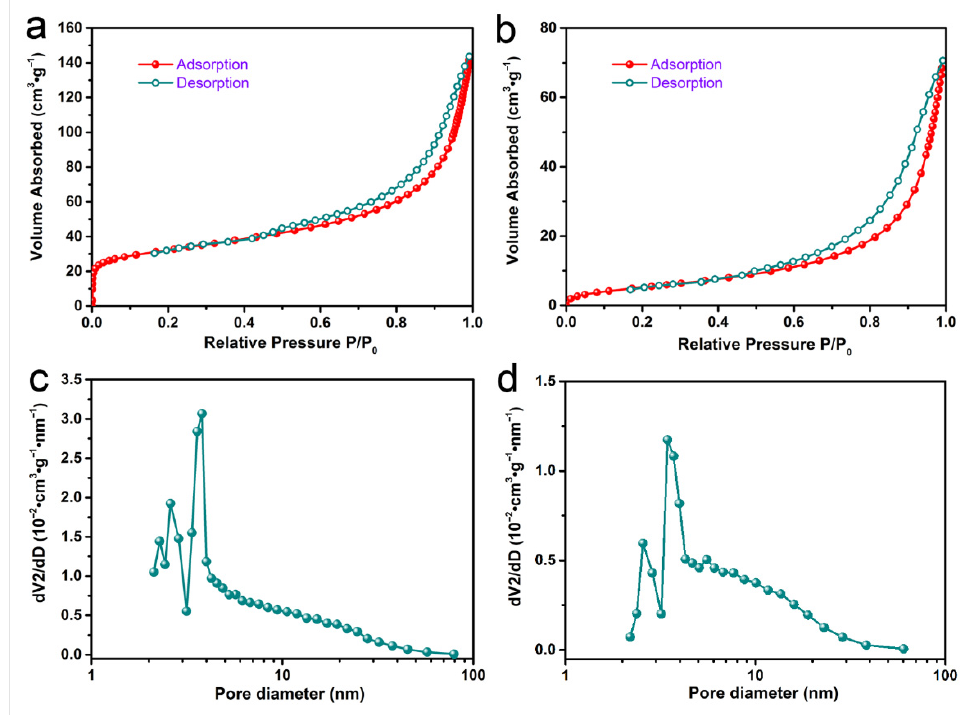
Figure 5. N 2 adsorption-desorption isotherms and pore size distribution of ATP ( a , c ), and CM-ATP ( b , d ).